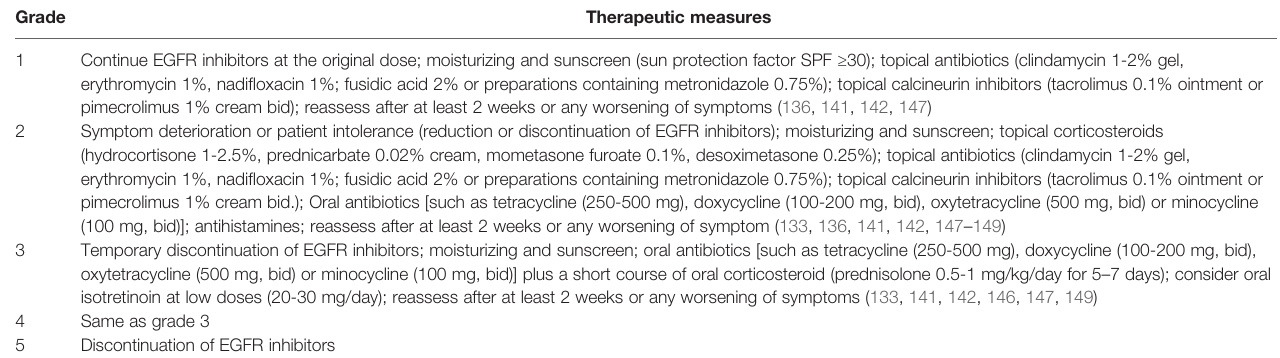
TABLE 4 | Treatments of papulopustular exanthemas caused by EGFR inhibitors.